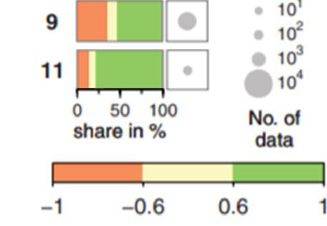
Figure 3: Correlation within the SDGs (fragment)